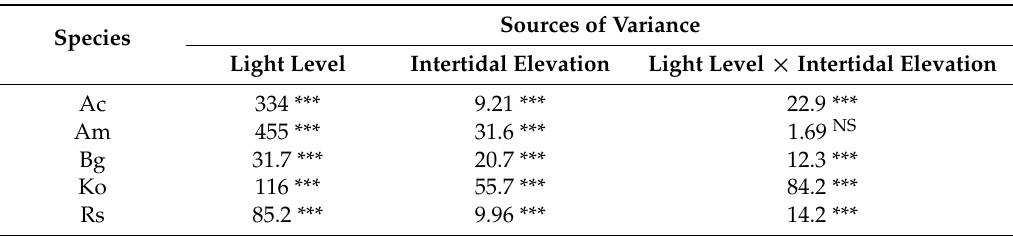
Table 1. F values of two-way ANOVA tests indicating the differences of five mangrove species surviving in varying light level and intertidal